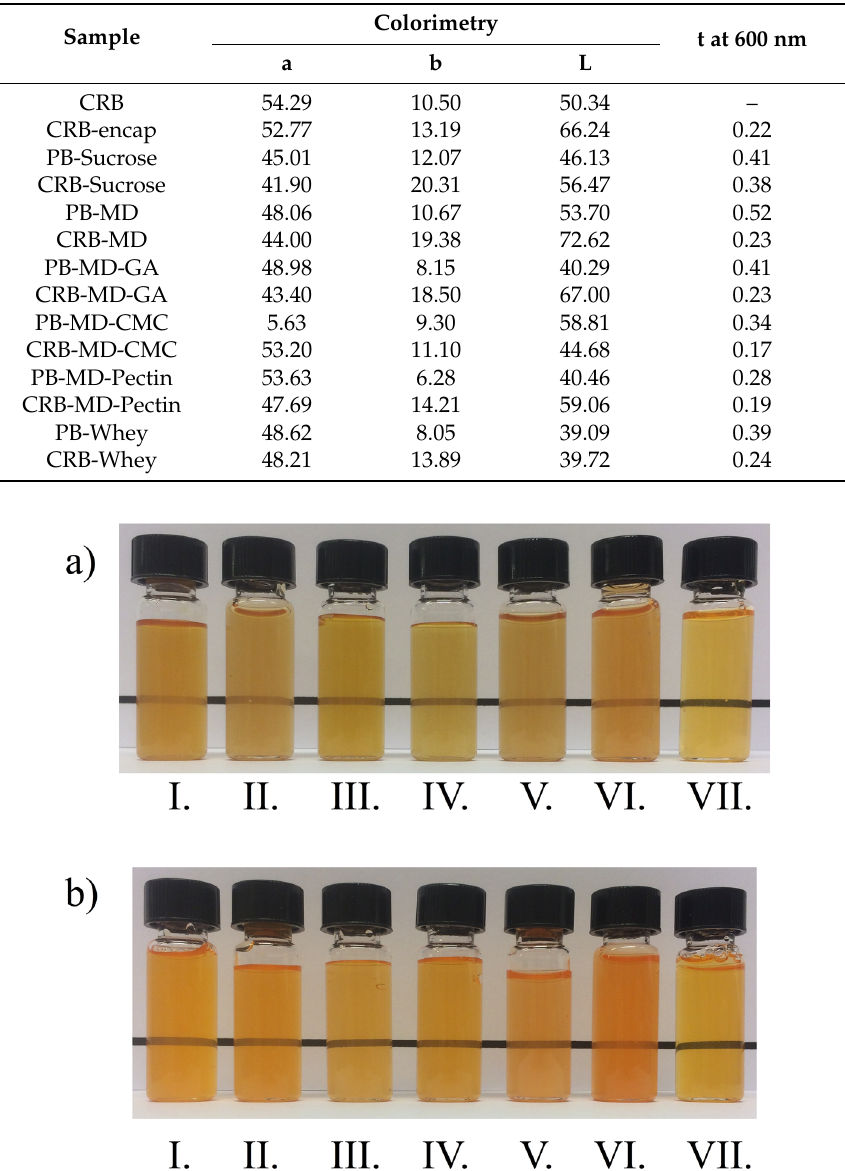
Figure 6. Aqueous dispersions of CRB ( a ) and PB ( b ) microcapsules at 0.3 mg/mL and 1.5 mg/mL respectively at alkaline pH. Aqueous dispersions of CRB and CRB-encap at 0.048 mg/mL. From left to right I: MD, II: MD-GA, III: MD-CMC, IV: MD-Pectin, V: Whey, VI: Sucrose, VII: ( a ) CRB-encap, VII: ( b )